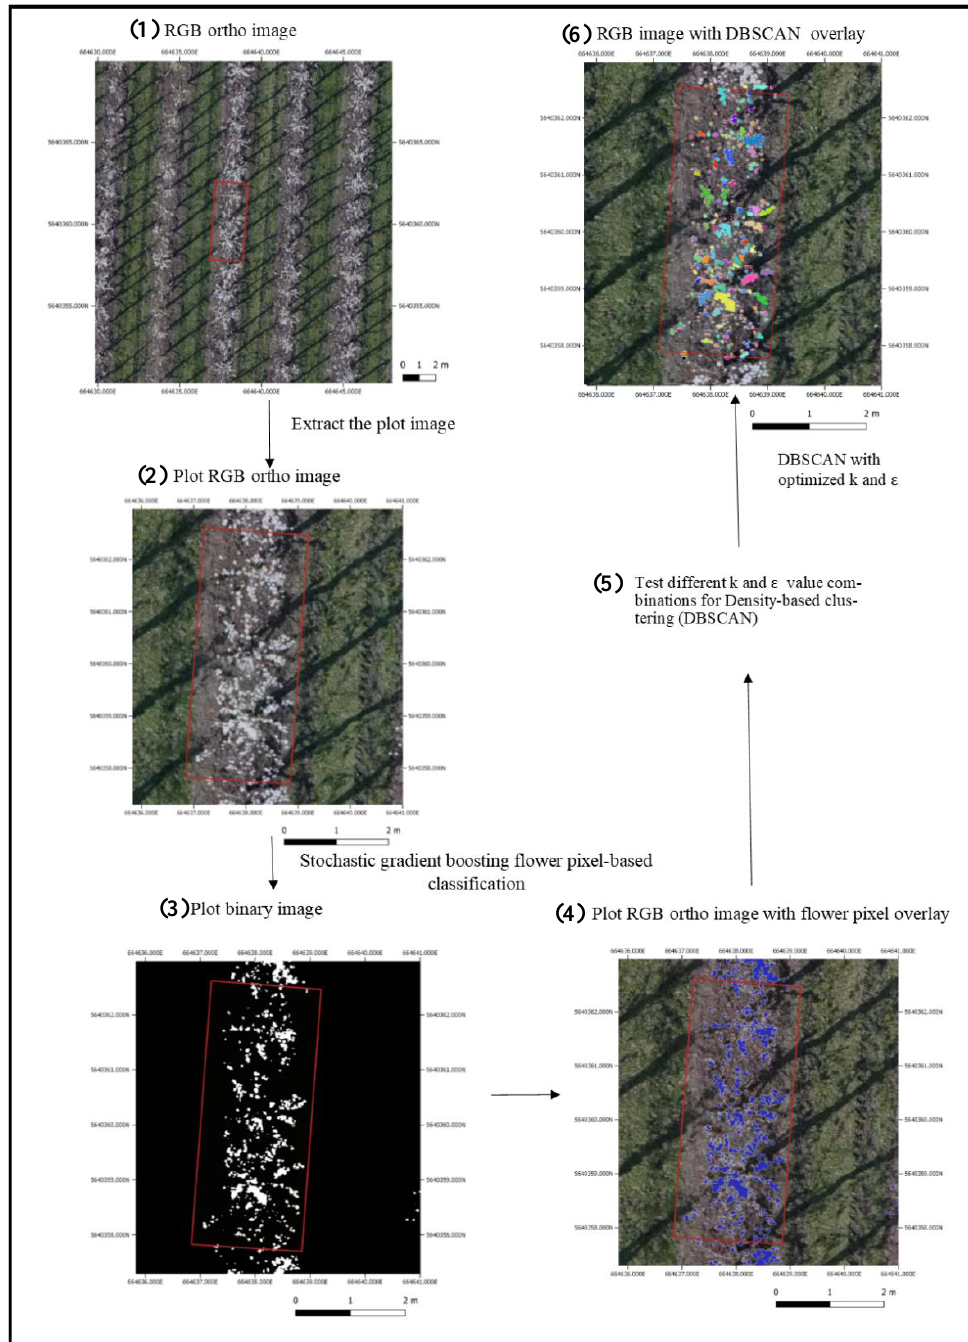
Figure 1. Overall flowchart of the flower cluster classification algorithm based on the orthomosaic, demonstrating the output of each step for plot 1B of Wimmertingen: (1) generate 2D RGB orthomosaics, (2) extract plot orthomosaic, (3) perform stochastic gradient boosting (SGB) flower pixel-based classification, (5) optimize DBSCAN parameters k and ε , (6) perform DBSCAN with optimal k and ε .